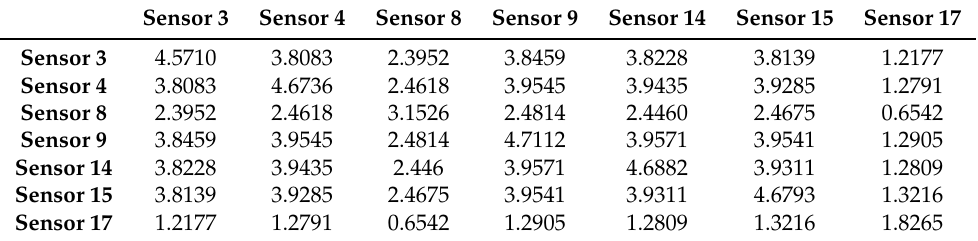
Table 10. Mutual information values among sensors selected by quantitative strategy for data set 4.